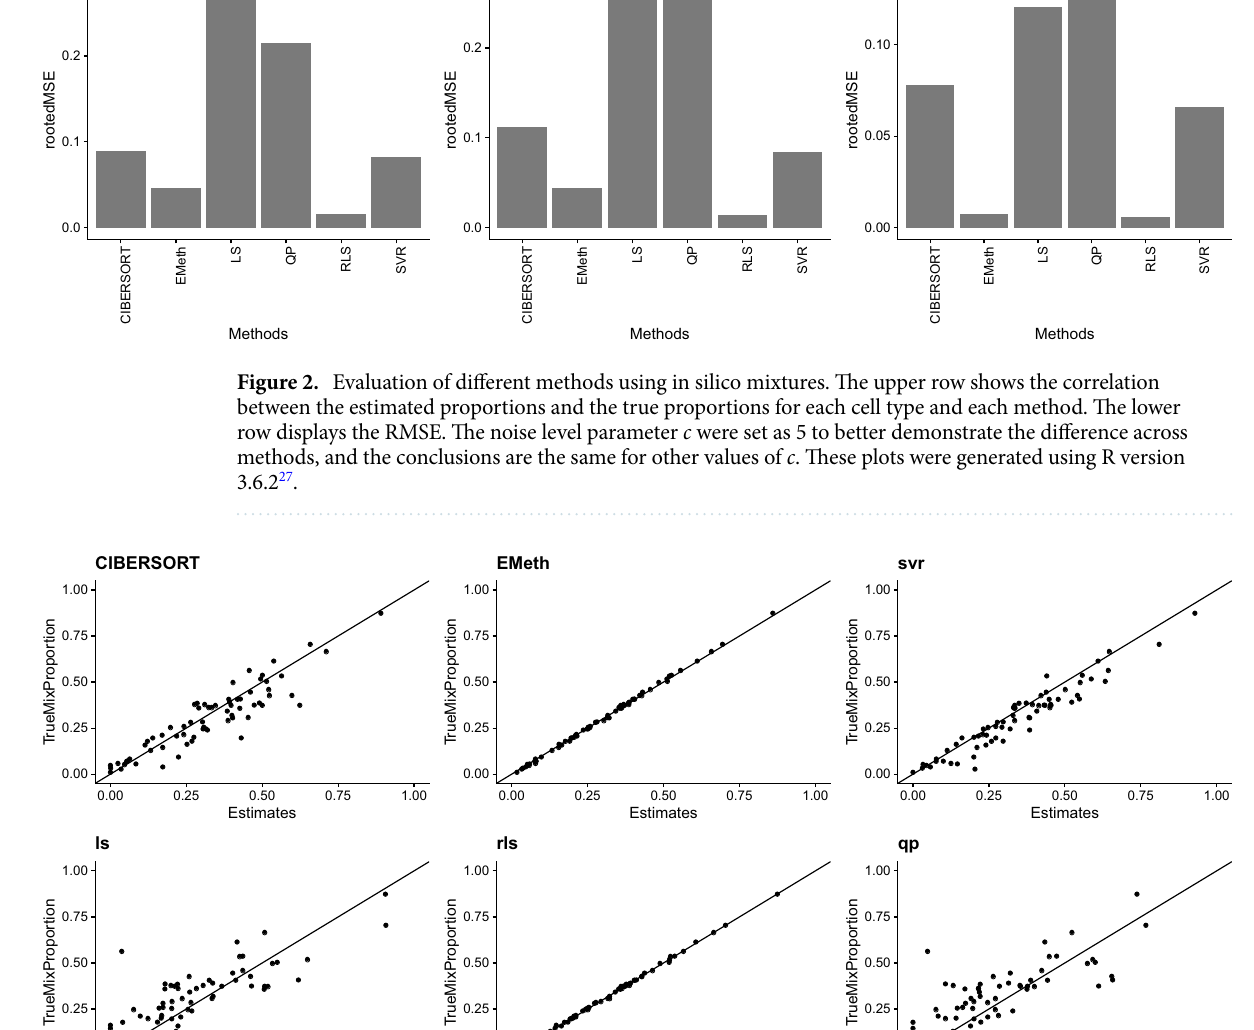
Figure 3. Evaluation of cell type proportion estimates for CD4 T cells using in silico mixtures. The y-axis is the true proportion of CD4 T cells for all 68 samples and the x-axis is the proportion estimates by six different methods. EMeth and RLS give very accurate estimates from methylation data and other methods provide reasonable but less accurate estimates. These plots were generated using R version 3.6.2 27